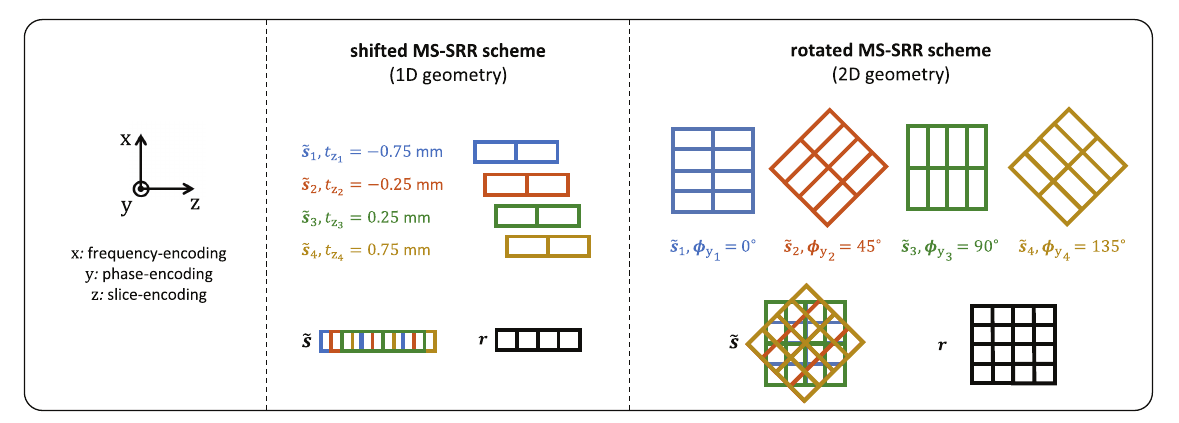
schemes for the case of AF represented in Figure